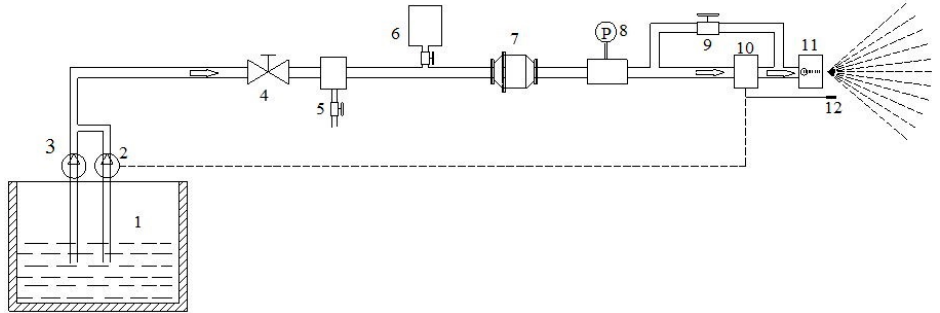
Figure 13. Upper-corner gas combustion and explosion suppression system: 1 closed water tank, 2